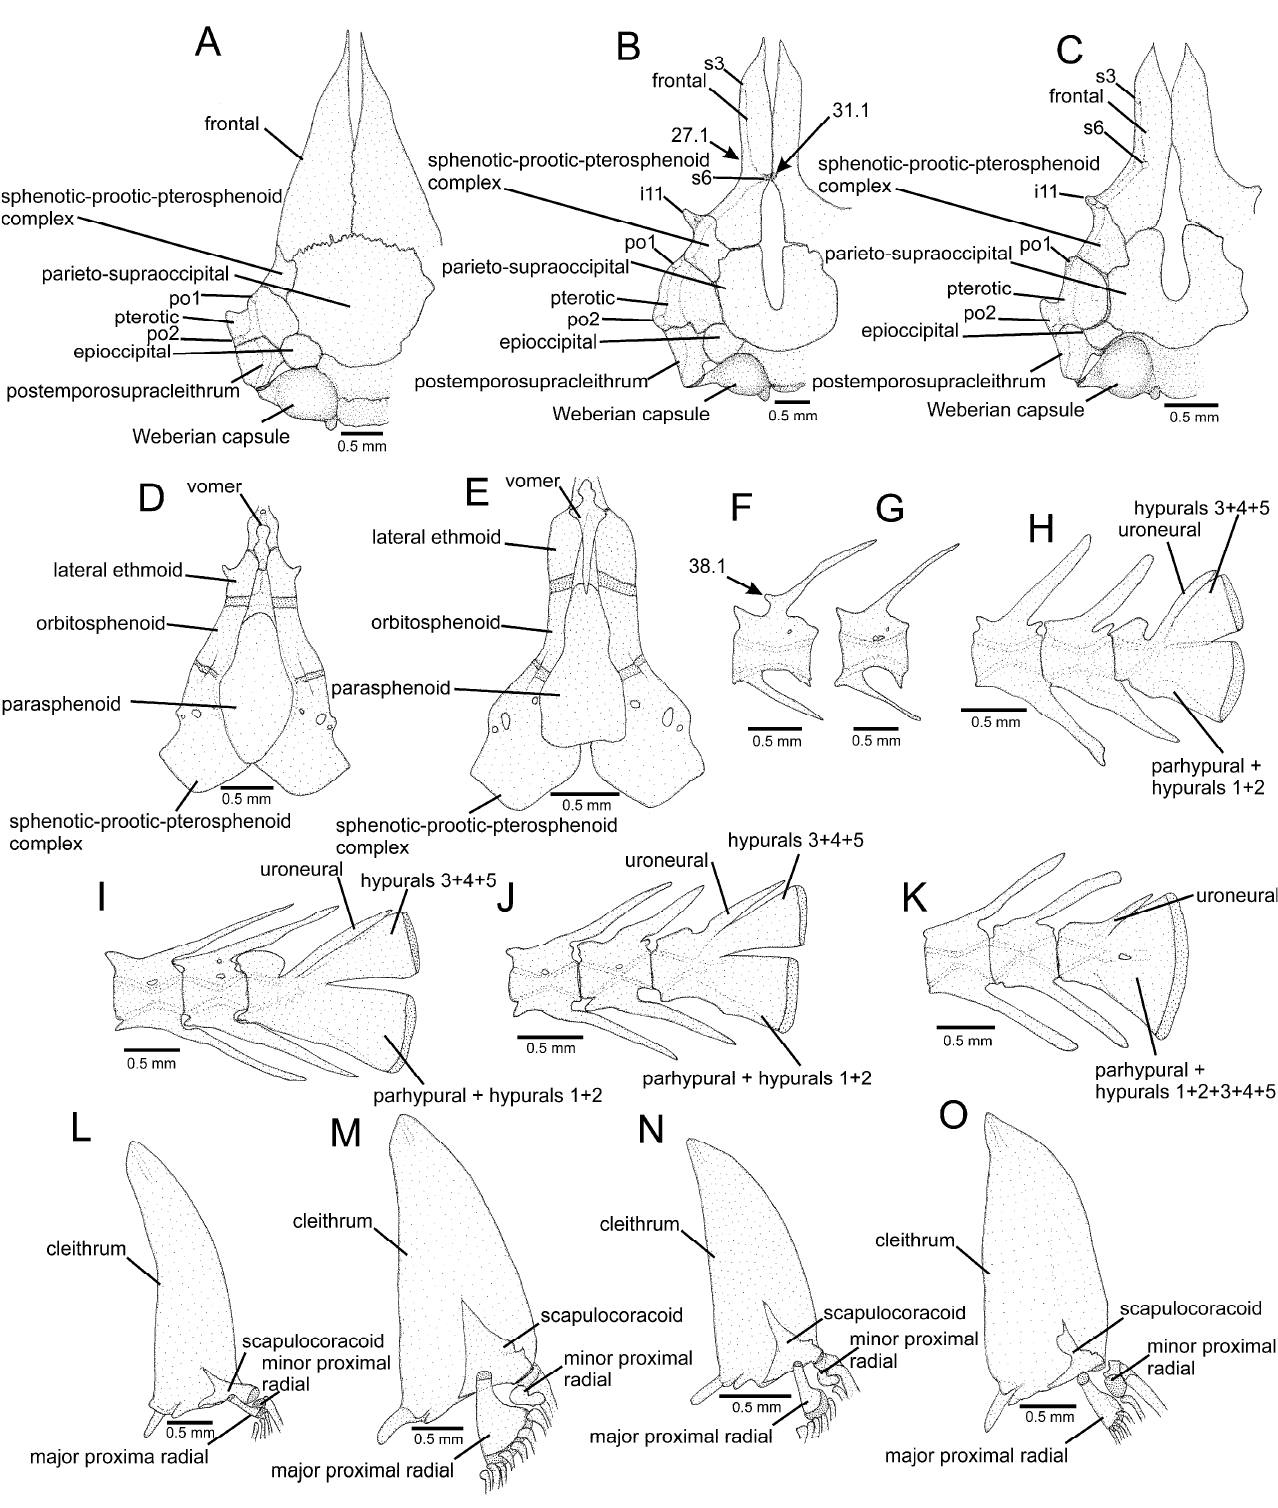
Figure 5. Osteological features in the Microcambevinae: ( A – C ) neurocranium, middle and left portions, dorsal view; ( D , E ) neurocranium, middle portion, ventral view; ( F , G ) nineth free vertebra, left lateral view; ( H – K ) caudal skeleton, left lateral view; ( L – O ) left shoulder girdle, ventral view, of: ( A ) Listrura ( Listrura ) picinguabae ; ( B , G , I , M ) Microcambeva ( Pterocambeva ) ribeirae ; ( C , E , N ) Microcambeva ( Microcambeva ) jucuensis ; ( D , K ) Listrura ( Listrura ) macacuensis ; ( F , H ) Listrura ( Prolistrura ) depinnai ; ( J , O ) Microcambeva ( Trichocambeva ) filamentosa ; ( L ) Listrura ( Paralistrura ) tetraradiata . Larger stippling represents cartilages. The numbers are characters, followed by character states after dots, which are numbered according to Appendix C.